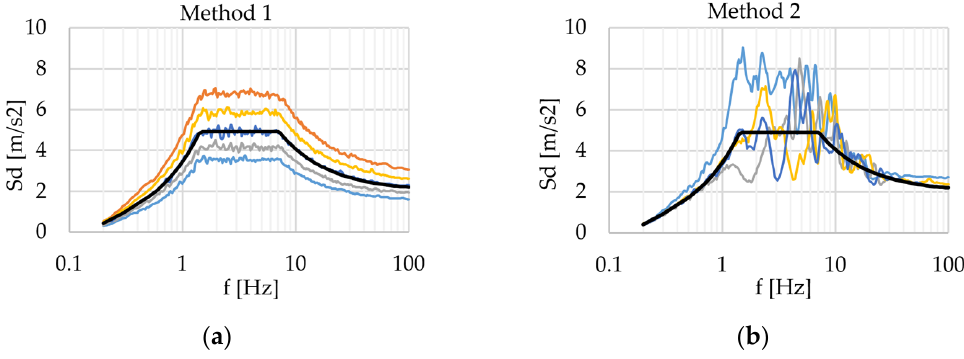
Figure 11. Example of generated time histories using ( a ) Method 1 and ( b ) Method 2.